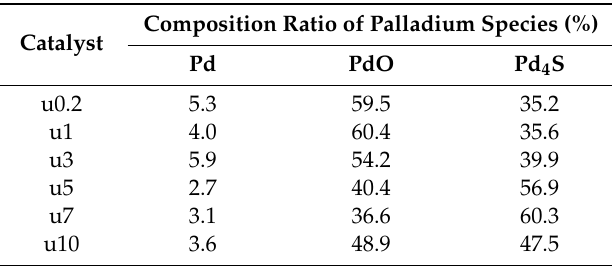
Figure 7. XPS Pd 3d and S2p of the used catalysts with different H 2 S concentration.